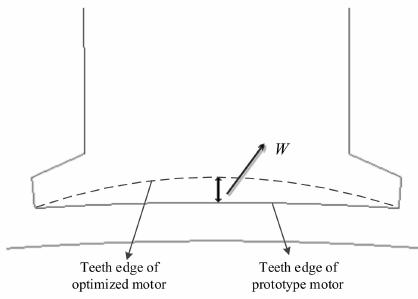
Figure 14. Stator tooth of optimized